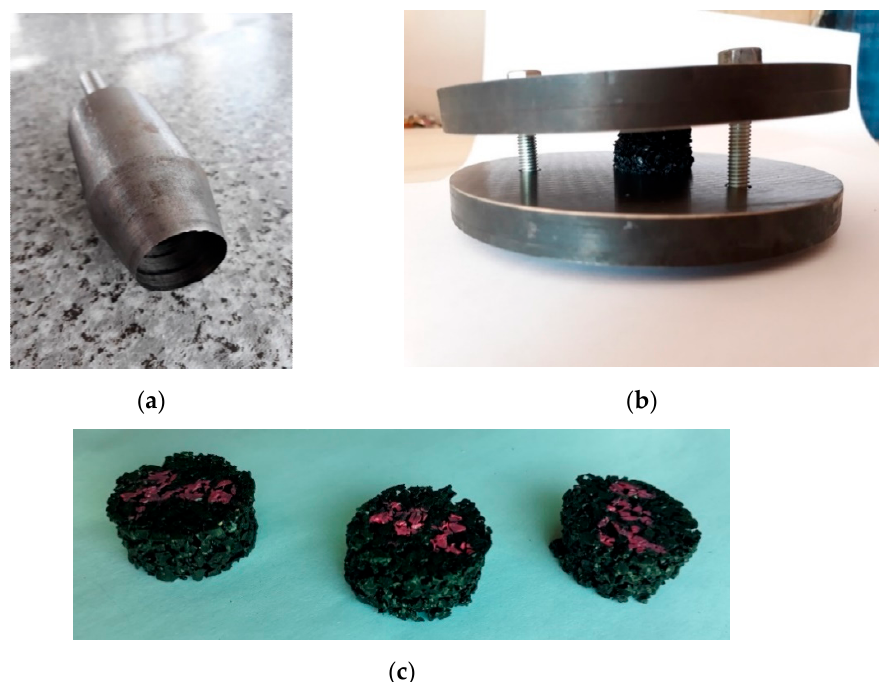
Figure 15. Views of: ( a ) Samples cutter; ( b ) Compressive plates; ( c ) Samples of elastomeric materials. Analysis of the tests performed on seven materials based on SBR granulate